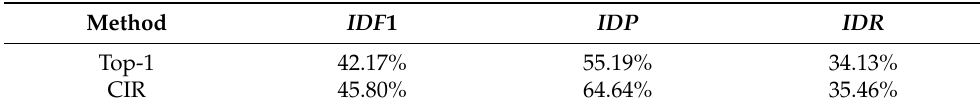
Table 3. Comparison of CIR tracklet association against the top-1